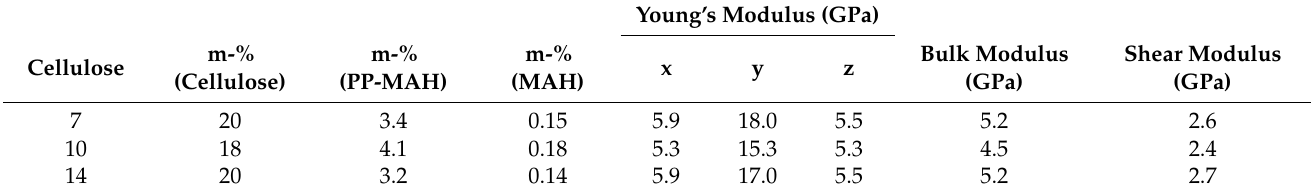
Table 3. Simulated mechanical properties of the cellulose–PP-MAH composite using different amounts of cellulose chains in fibril.